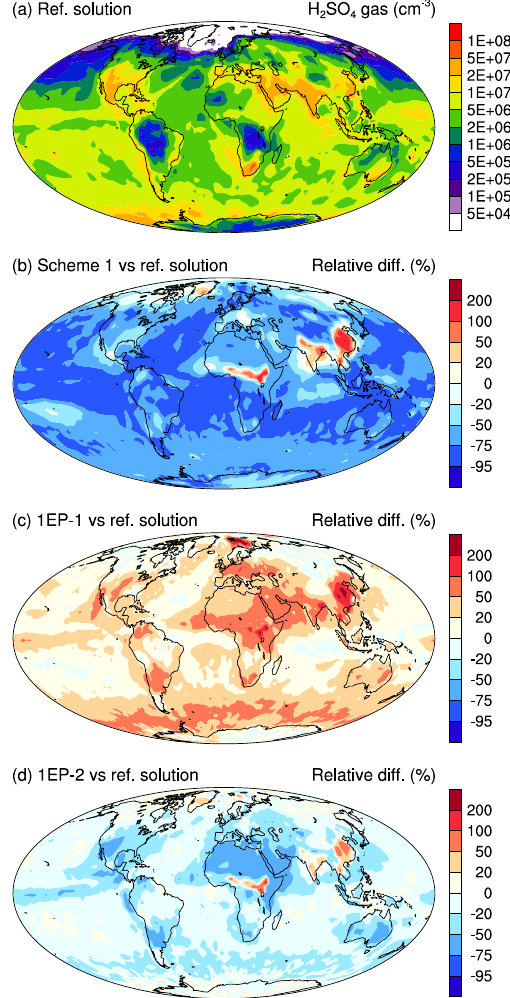
Fig. 5. (a) Reference solution of the January-mean near-surface H 2 SO 4 gas concentration (unit: molecules per cm 3 ). (b–d) Rela- tive differences with regard to the reference solution in simulations using scheme 1 (cf. Sect. 2.2), and using scheme 1EP without and with 2 sub-steps. All panels are plotted for the lowest model level. Similar figures of the other months convey the same message, al- though the spatial distributions are different because of the seasonal